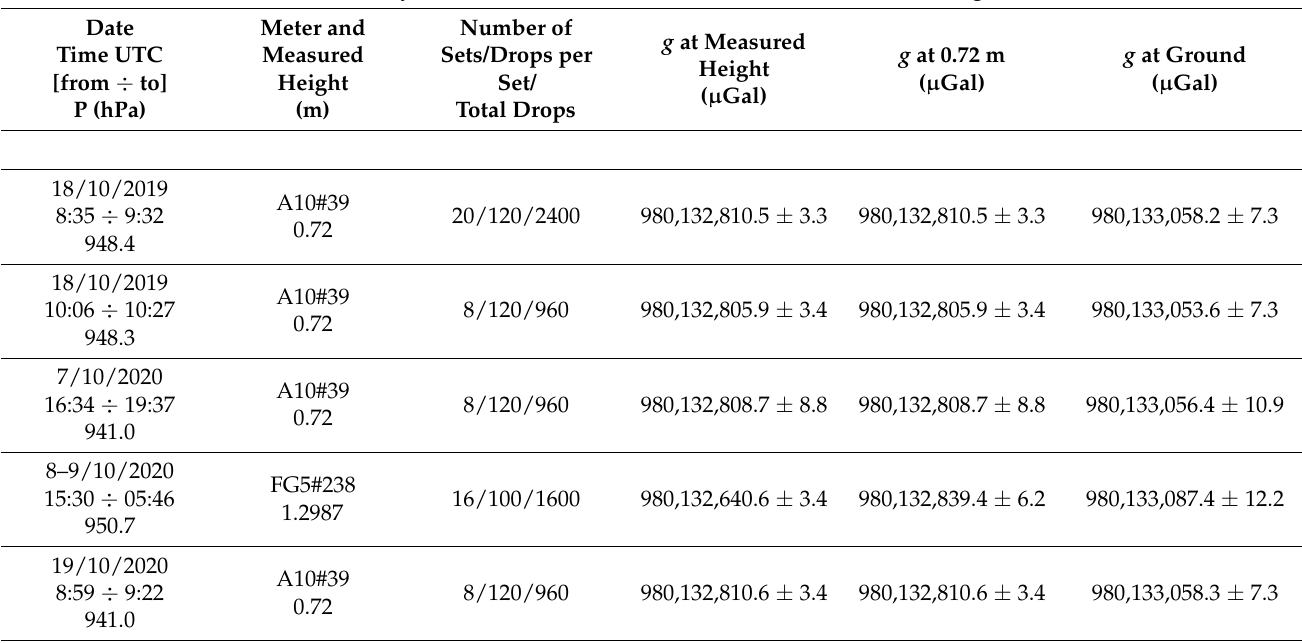
Table 1. Absolute gravity measurements collected at the station Osservatorio Vesuviano Old Building station (OVOB) from October 2019 to October 2020 by FG5#238 and A10#39 absolute ballistic gravimeters. The combined uncertainty δ tot associated to the g values are also